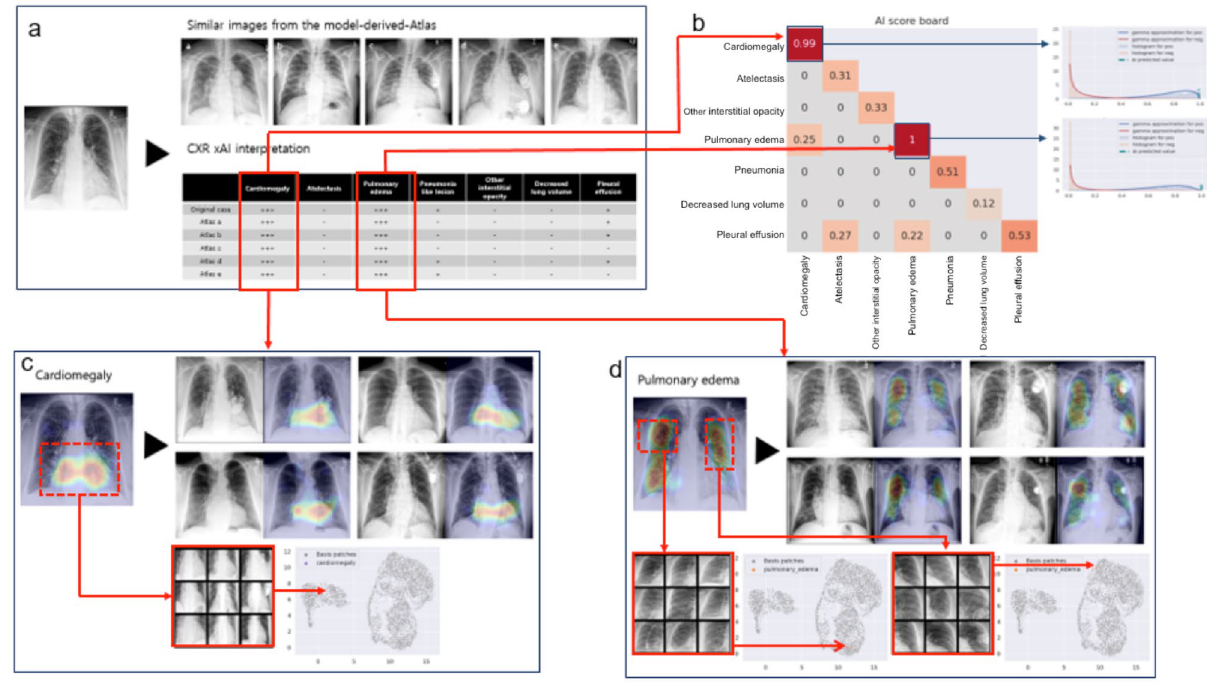
Figure 6. CXR interpretation by our xAI model for a patient who presented with heart failure. ( a ) The interpretation table shows 5 comparable CXRs selected from the Model-Derived Atlas and prediction probabilities for labels associated with heart failure. ( b ) Prediction probability was ≥ 0.90 on the AI scoreboard for cardiomegaly and pulmonary edema. ( c,d ) Cardiomegaly and pleural effusion were correctly localized by Grad-CAM, and similar feature CXRs and patches were selected from the Model-Derived Atlas. UMAPs show that the test patches were close to corresponding patches from the Model-Derived Atlas, which supports that the testing patches can be classified as “cardiomegaly” and “pulmonary edema”,